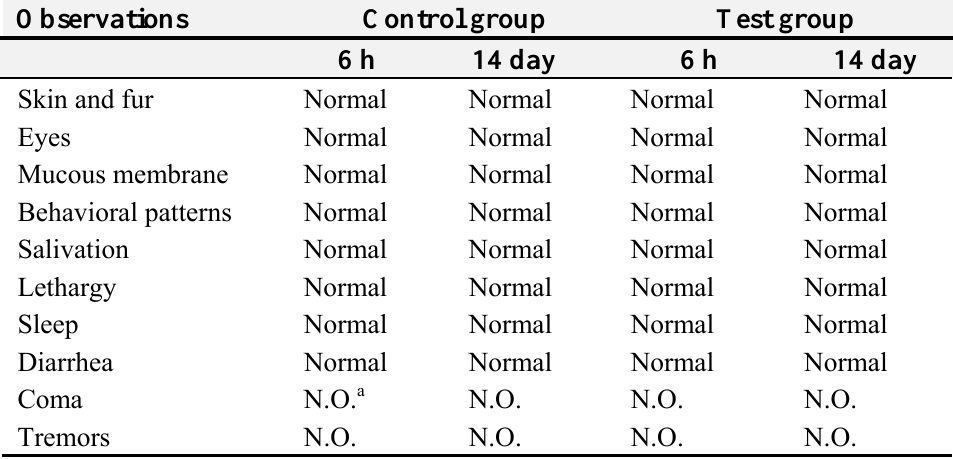
Table 2. General appearance and behavioral observations for control and treated groups.